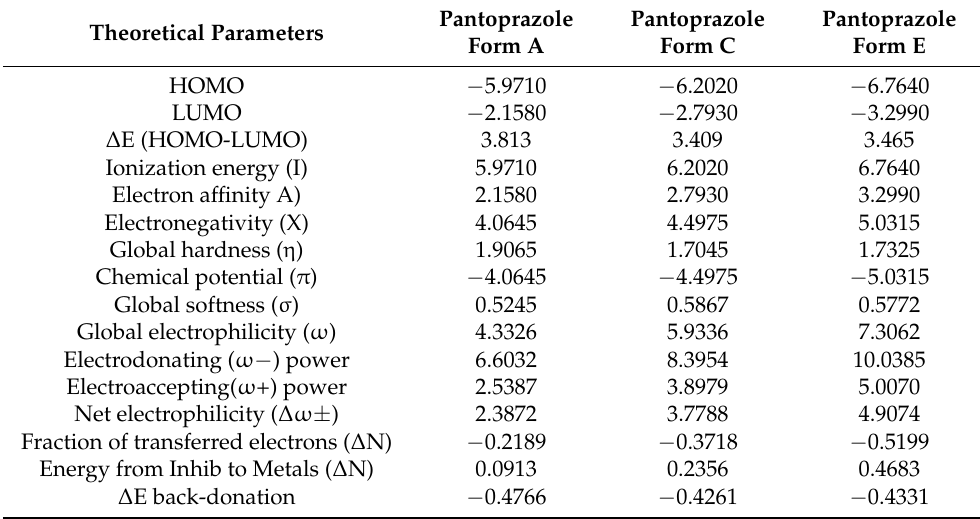
Table 3. Calculated theoretical chemical parameters for the different protonated forms of the Panto- prazole inhibitor.